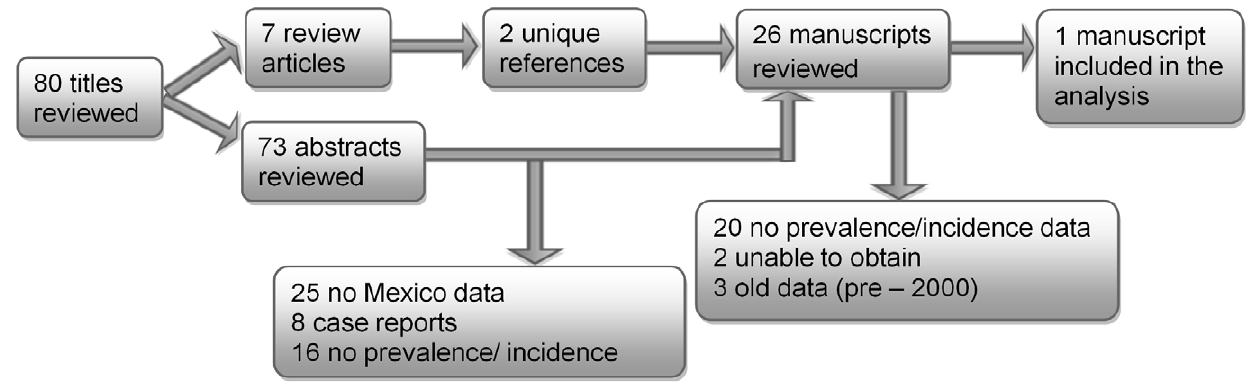
Figure 1. Flowchart of study selection for the literature review of epilepsy prevalence in Mexico.